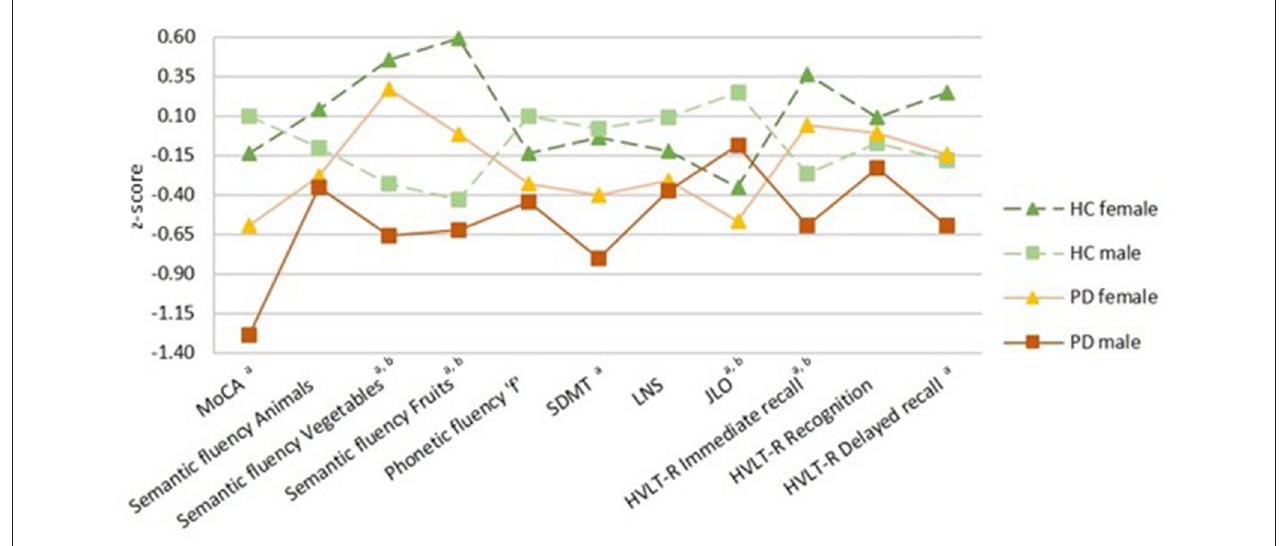
FIGURE 1 | Neuropsychological performance. Healthy controls (HC) groups in green, Parkinson’s disease (PD) groups in warm colors; darker for females and lighter for males. Females represented by filled triangles and males by filled squares. PD by a discontinuous line and HC by a continuous line. Data are presented as z-scores. Lower z-scores indicate worse performance. Two-way analyses of covariance (ANCOVA) with age and education as covariates with post-hoc tests corrected by Bonferroni were used for all variables. MoCA, Montreal Cognitive Assessment; SDMT, Symbol Digit Modalities Test; LNS, Letter-Number Sequencing; JLO, Benton Judgment of Line Orientation; HVLT-R, Hopkins Verbal Learning Test-Revised. a Sex differences in PD group, b sex differences in HC group ( p < 0.05).